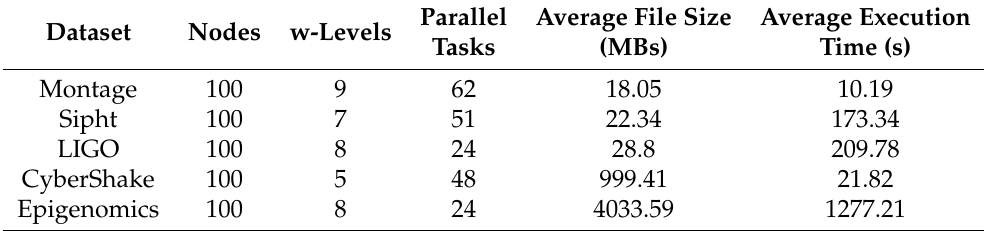
Figure 1. Structures of the workflows used for the experiments: ( a ) Sipht, ( b ) CyberShake, ( c ) Epigenomics, ( d ) LIGO, and ( e ) Montage. Table 1. Datasets used for the